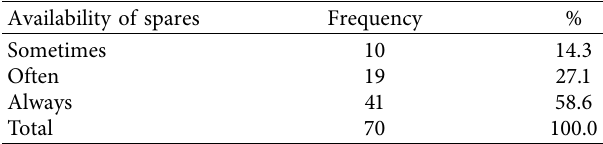
Table 19: Availability of spares.